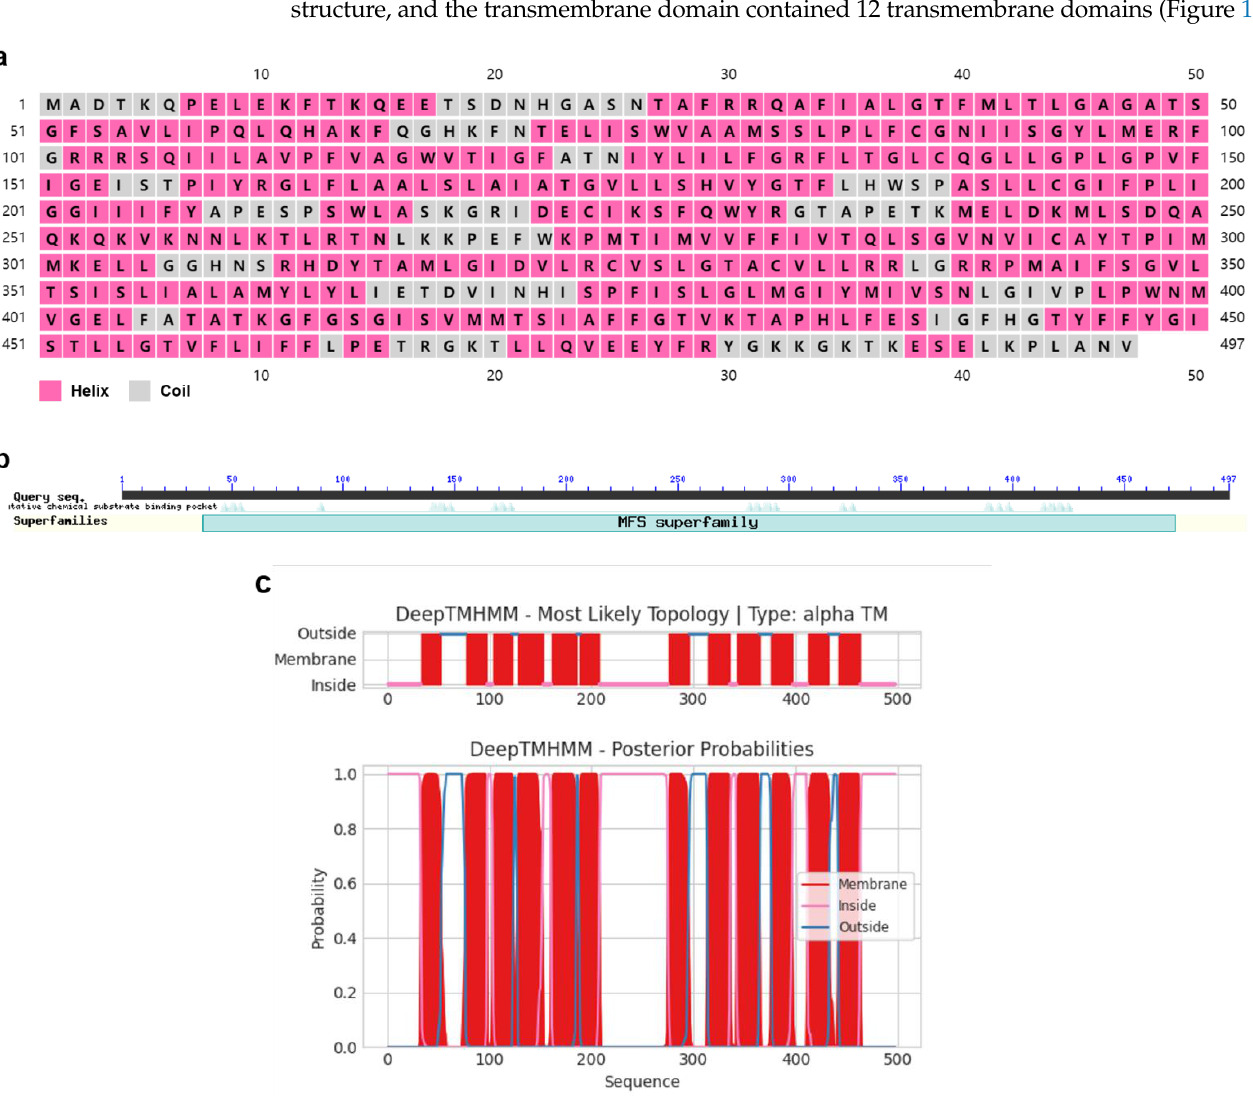
Figure 1. Characterization of Plutella xylostella PxTret1-like gene. ( a ) Secondary structure of PxTret1-like. Pink represents helix; grey represents coil. ( b ) Domain of PxTret1-like. ( c ) Transmembrane domain of PxTret1-like. Red line represents membrane; pink line represents inside; blue line represents outside.